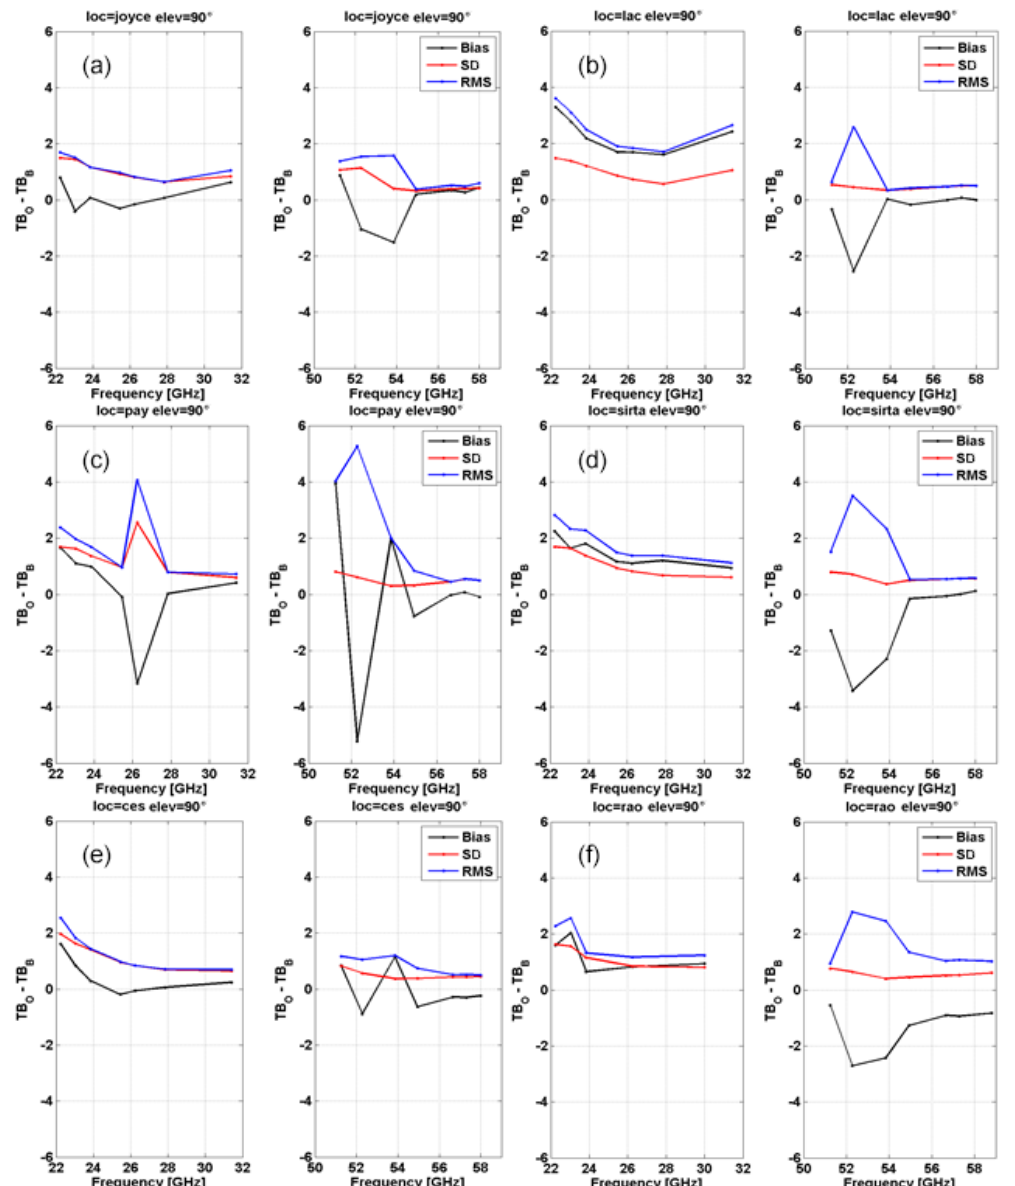
Figure 3. Statistics of the differences between observations and background TB. Observations are TB measured by ground-based MWR. Background counterparts are TB simulated with RTTOV-gb from AROME-France 3h forecast profiles in clear-sky conditions at zenith. Panels (a) , (b) , (c) , (d) , (e) , and (f) refer, respectively, to JOYCE, LACROS, Payerne, SIRTA, CESAR, and RAO. Biases are shown with black lines, standard deviations with red lines, and RMS with blue